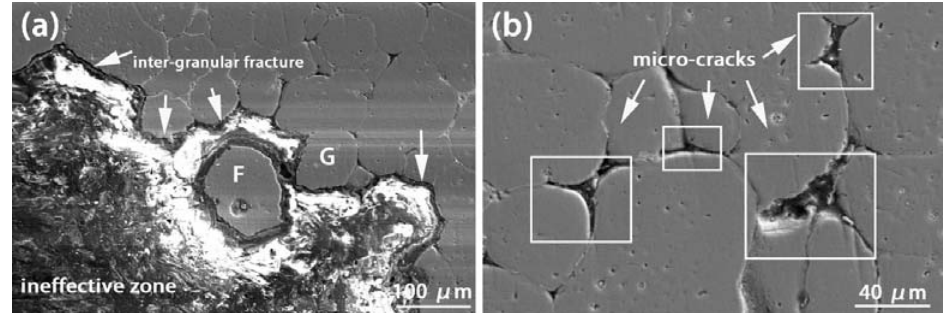
Figure 10. The SEM images of the fracture profiles of the room temperature tensile samples that soaked at 620 °C for 15 min, ( a ) low magnification; ( b ) high magnification.